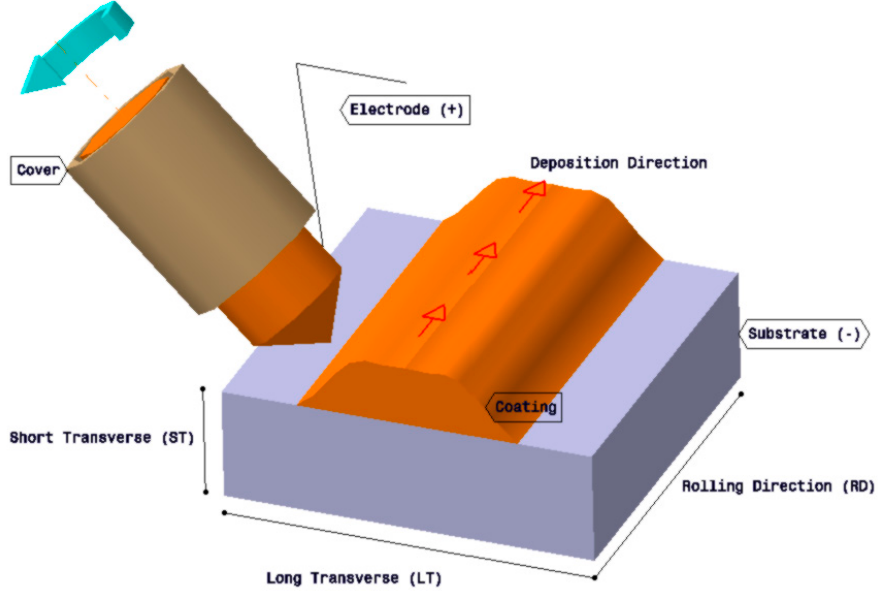
Figure 1. Scheme of ElectroSpark Deposition (ESD) process.